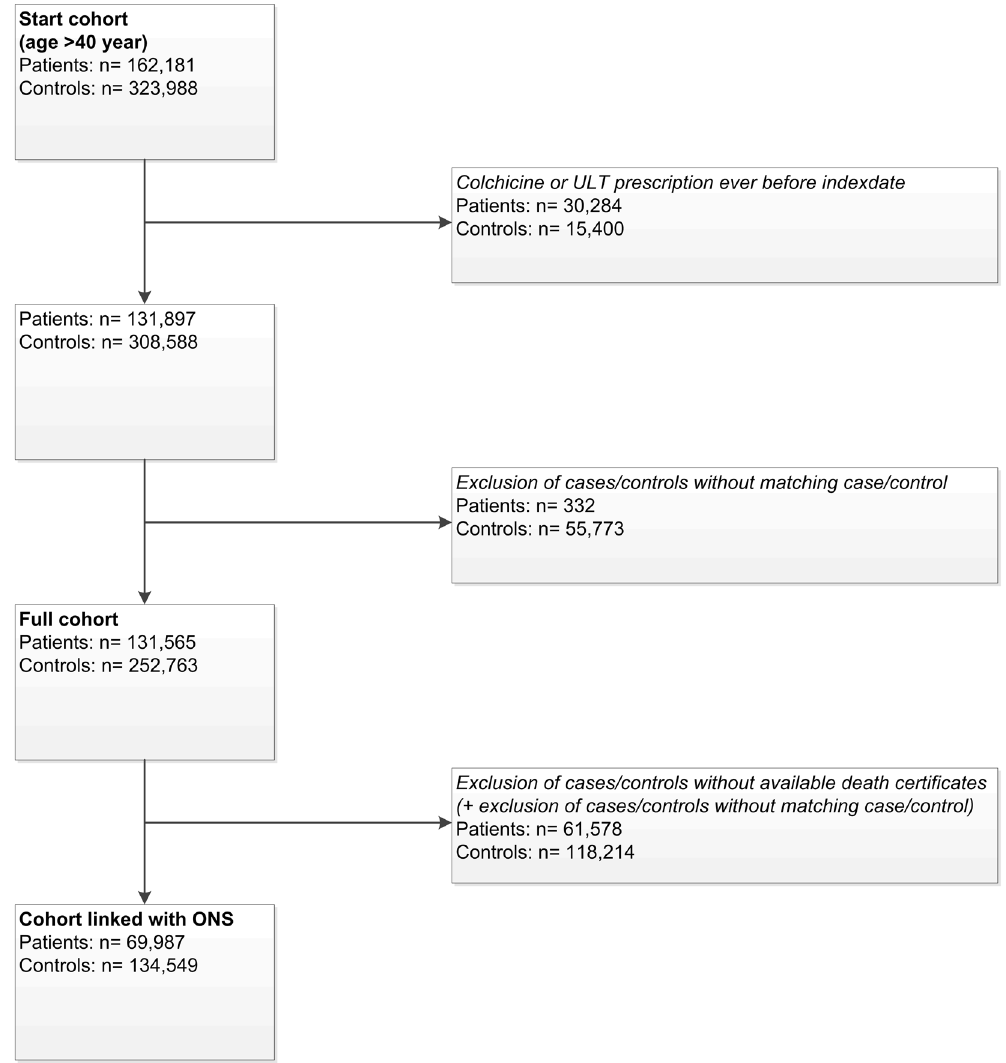
Figure 1. Flowchart of the study